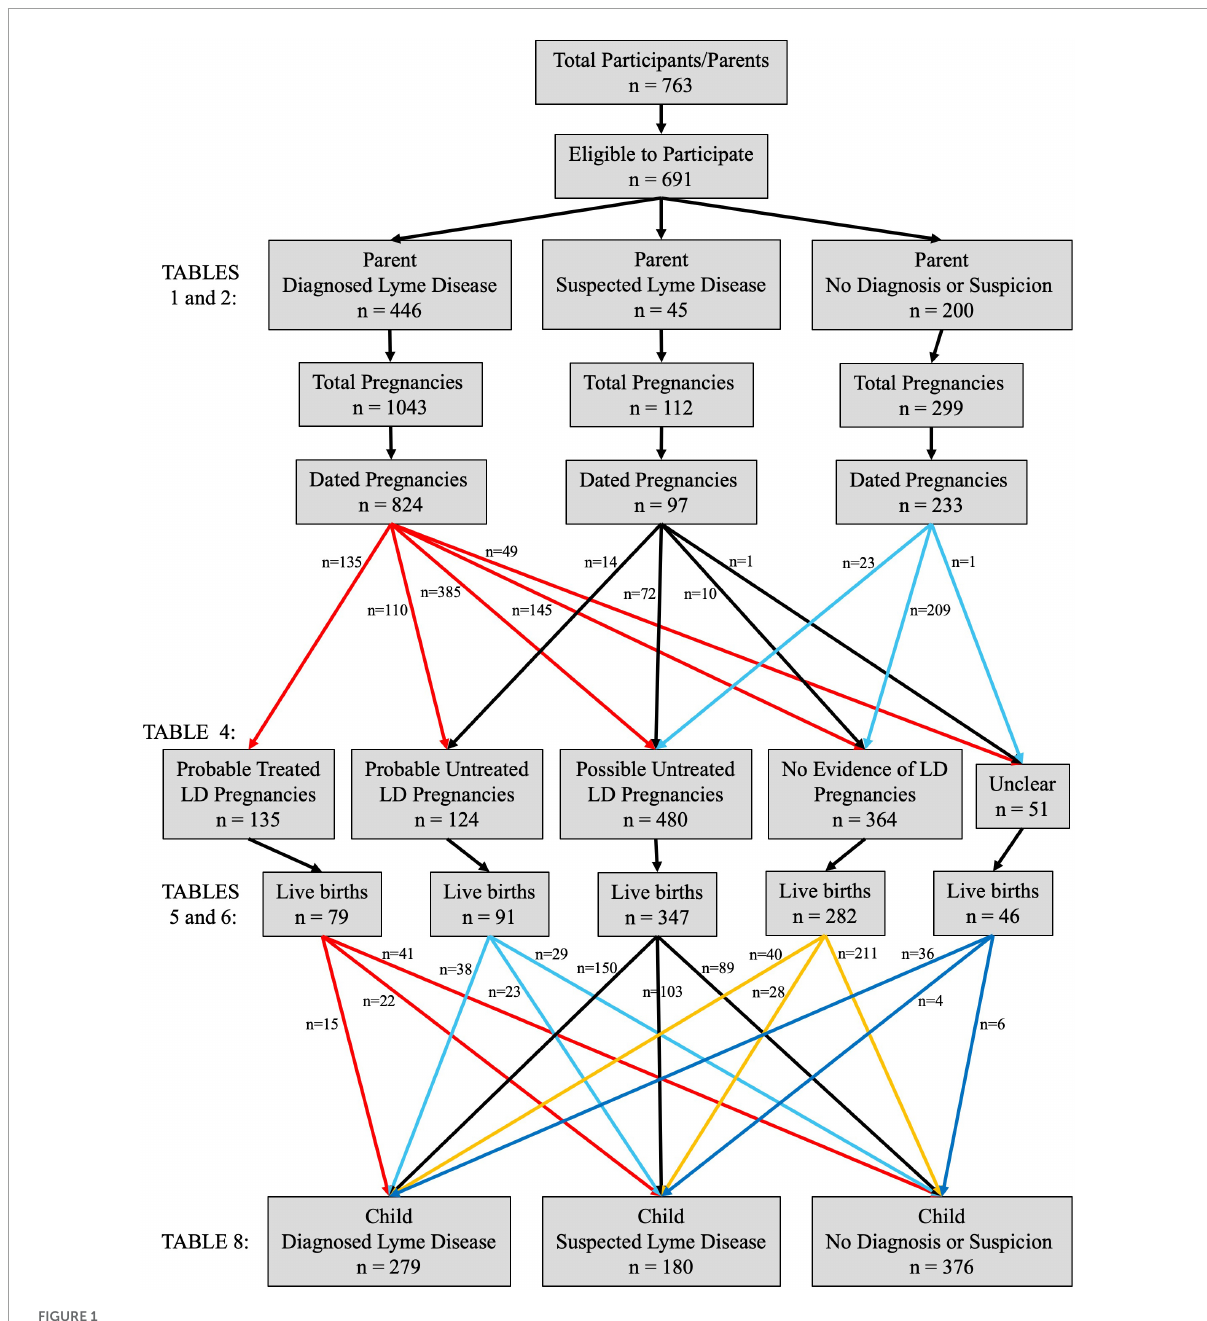
FIGURE1 Participant groups and pregnancy classifications. Of the 763 individuals who commenced the survey, 691 were eligible to participate (at least 18 years old, had been pregnant at least once, and provided written informed consent). Most participants ( n = 446) had been diagnosed with Lyme disease (LD) at some point in their lives, while some suspected they had or have Lyme disease but were never diagnosed ( n = 45). The remaining participants ( n = 200) had never been diagnosed with or suspected they had LD. Overall, the 691 participants had been pregnant a total of 1,454 times, and a valid date of birth/miscarriage date/due date was provided for 1,154 of these pregnancies (79%), allowing for the classification of the pregnancy based on the Lyme disease status of the participant/parent. Pregnancies were classified as “Probable LD” if the parent was diagnosed with Lyme disease and/or observed an erythema migrans (EM) rash prior to or during the pregnancy (may be “Treated” or “Untreated” prior to or during the pregnancy). “Possible LD” pregnancies were those where the parent experienced a tick bite and/or onset of non-EM Lyme disease symptoms prior to or during the pregnancy (all “Untreated”). If at least two dates were provided for diagnosis, tick bite, EM onset, and other symptom onset, and they were all after the pregnancy, it was classified as a “No Evidence of LD” pregnancy, along with any pregnancy in a healthy control with no noted tick bite at any point or no tick bite prior to or during the pregnancy. Fewer than 5% of pregnancies ( n = 51) could not be classified due to missing or conflicting dates (“Unclear” pregnancies). The majority (73%, n = 845) of dated pregnancies resulted in a live birth and the Lyme disease status of the child themselves at the time of parent participation in the survey was noted for 99% ( n = 835) of live